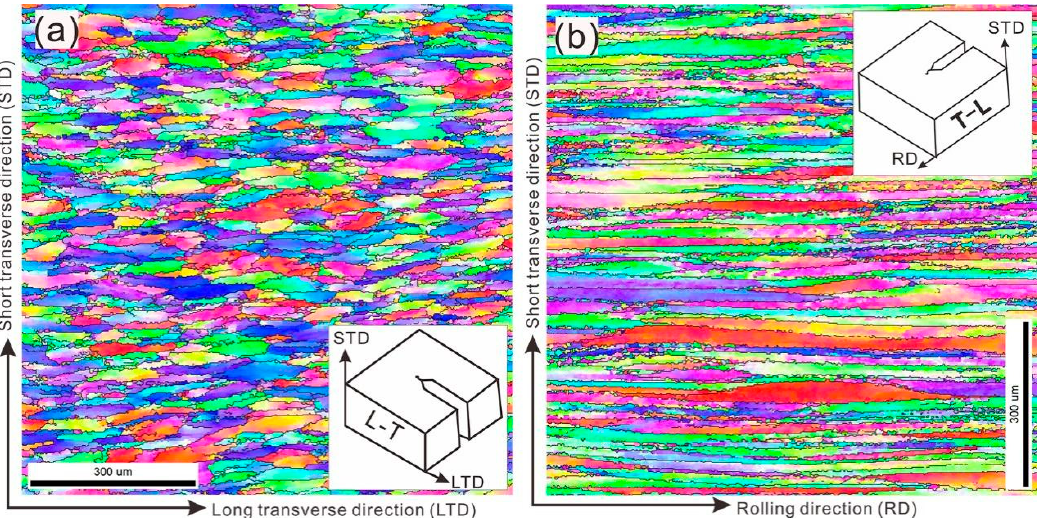
Figure 4. Inverse Pole Figures (IPF) show the grain structure of 7X75 aluminum alloy at 1/4 thick- nesses of L-T direction ( a ) and T-L direction ( b ).